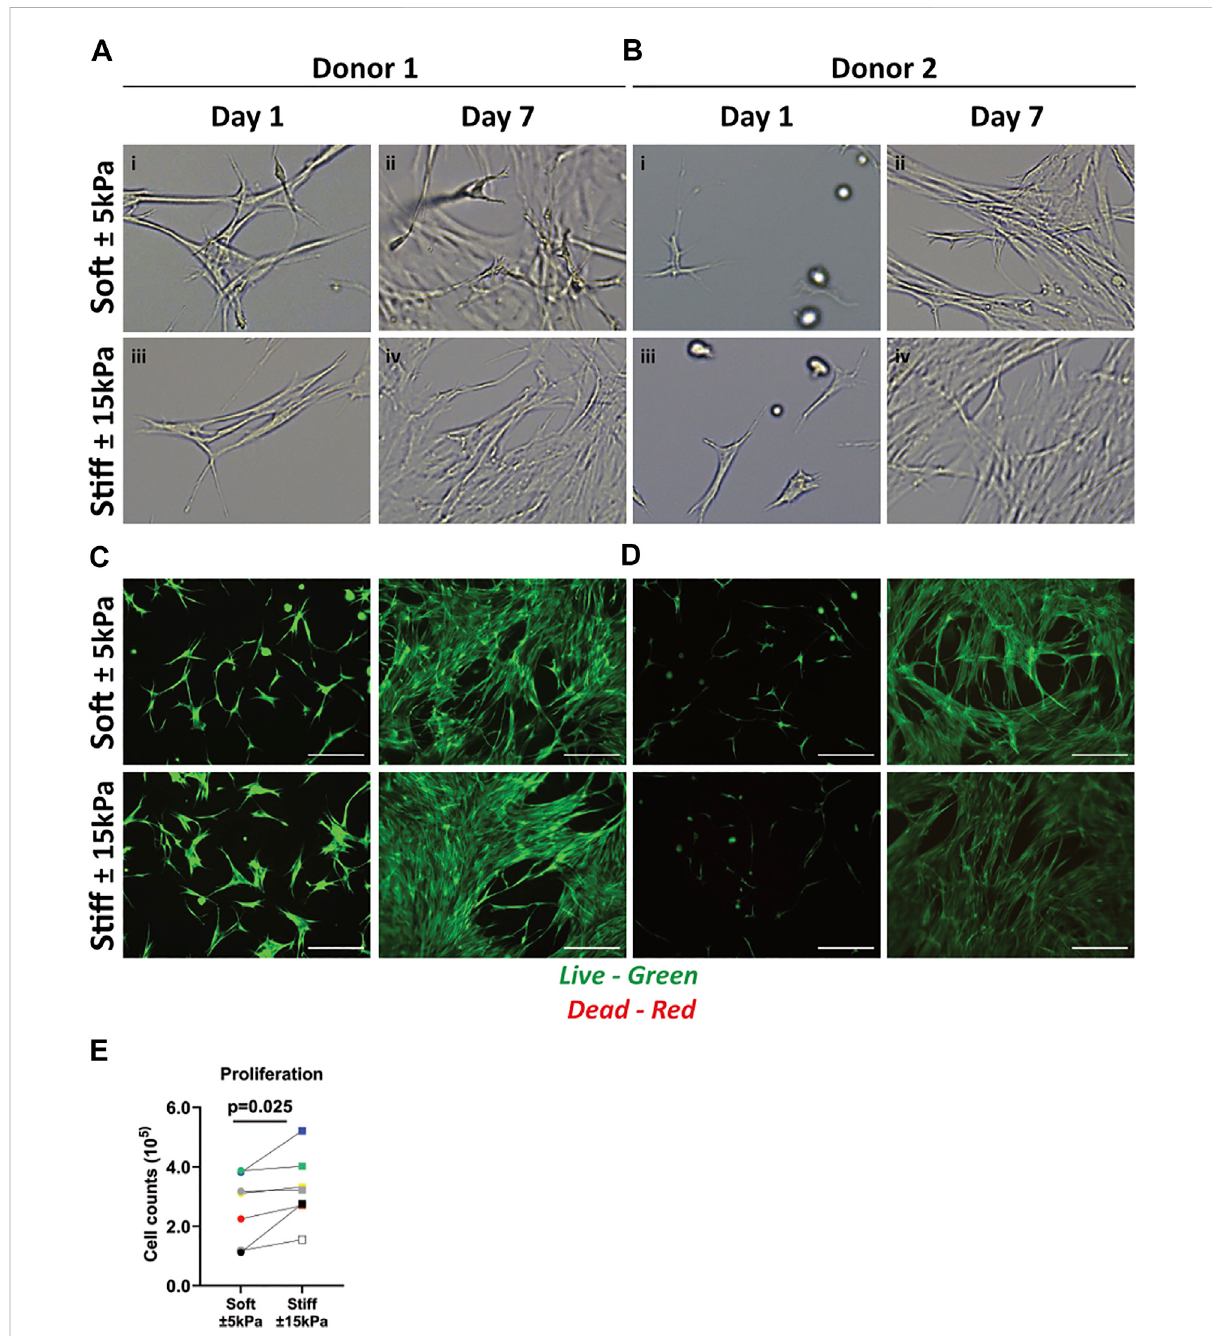
FIGURE 2 Primary human lung fi broblast morphology, live/dead staining and proliferation on soft (3.94 ± 0.87 kPa) and stiff (11.34 ± 3.82 kPa) GelMA hydrogels. (A – B) Representativebright fi eldmicroscopyimagesofcells24 hpostseedingandafter7 daysofcultureontopofsoftandstiffhydrogels (digital magni fi cation). Letters i-iv show areas of interest with different morphologies between donors. (C,D) Live (green) and dead (red) stain of two donors atday1 and 7ofculture. (E) Total cell numbers onsoft(3.94± 0.87 kPa)and stiff (11.34 ± 3.82 kPa)hydrogels after 7 days of cell culture. Images are representative of responses seen in 7 unique donors. ( n = 7) Scale bar = 250 µm. Each donor has a different unique colour (blue, red, yellow, green, black, white, and